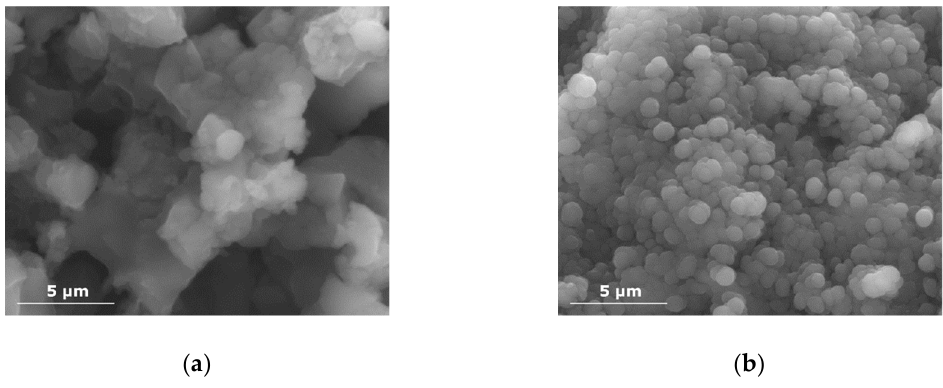
Figure 5. The microstructure of metahalloysite-based composites: ( a ) MH2 ; ( b ) MH5 .